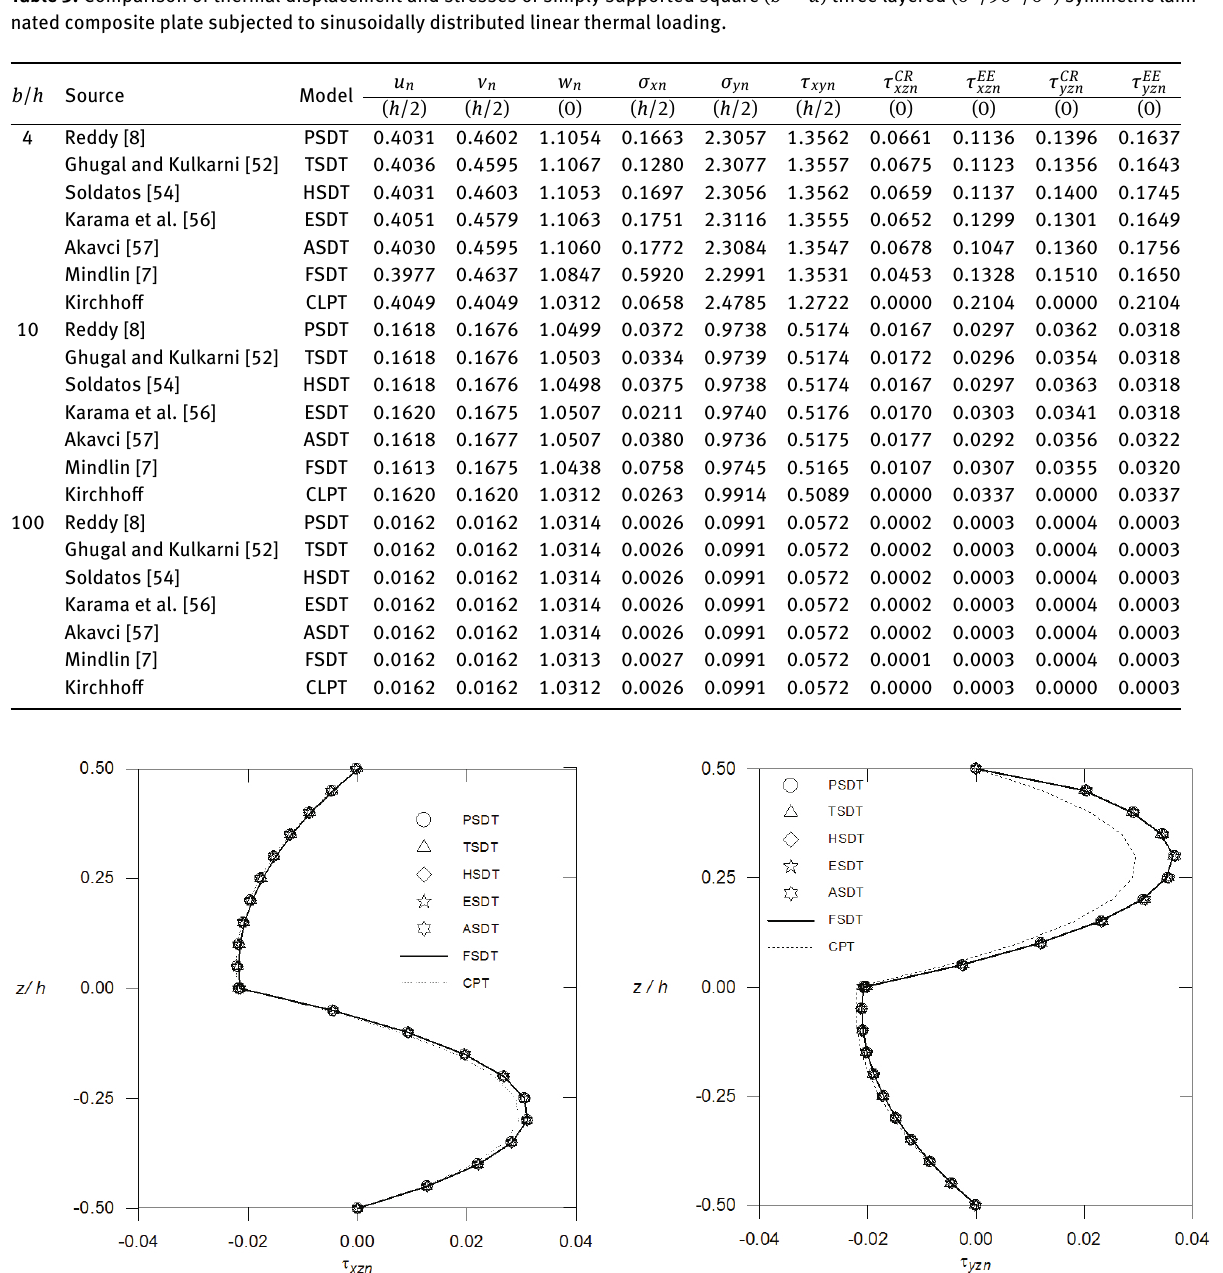
Figure 4: Variation of normalized transverse shear stress τ xz across the thickness for two layered (0 ∘ /90 ∘ ) anti-symmetric laminated composite square plate for aspect ratio 10.